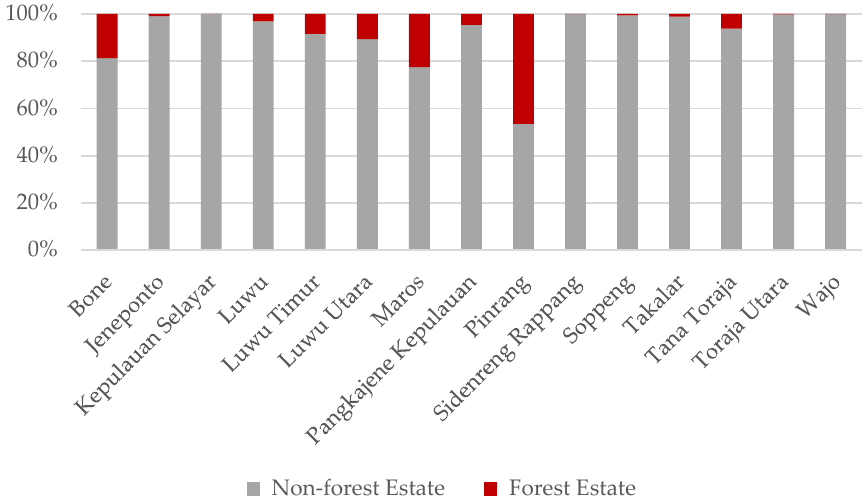
Figure 9. Comparison of the incidence of illegal logging within forest and non-forest areas in Sulawesi Selatan Province.